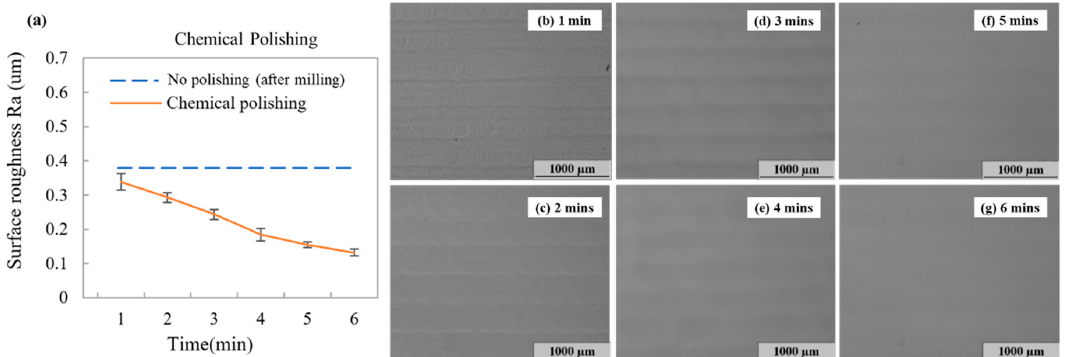
Figure 3. ( a ) Surface roughness of the PMMA surface after chemical polishing with solvent evaporation times of 1, 2, 3, 4, 5, and 6 min. Microscope images of PMMA surfaces at ( b ) 1, ( c ) 2, ( d ) 3, ( e ) 4, ( f ) 5, and ( g ) 6 min. Error bars were obtained based on three individual measurements.